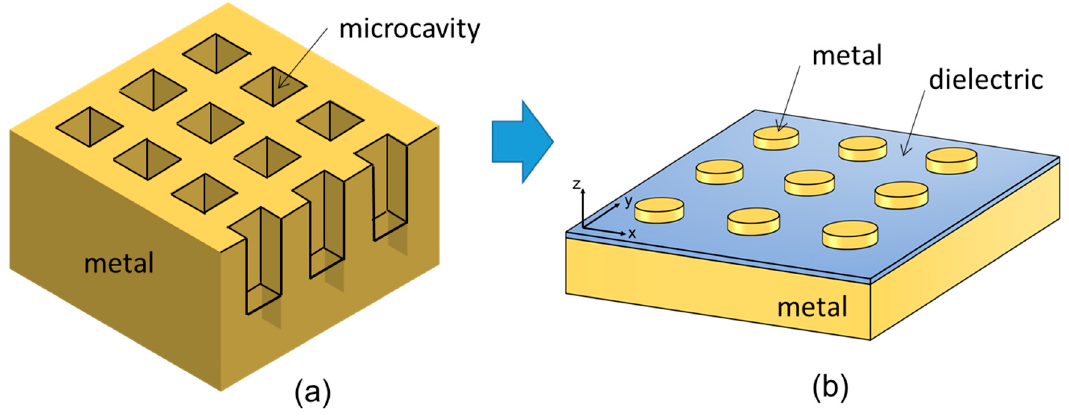
Figure 8. Refractory metasurface ( a ) from a microcavity array to ( b ) a plasmonic cavity array.